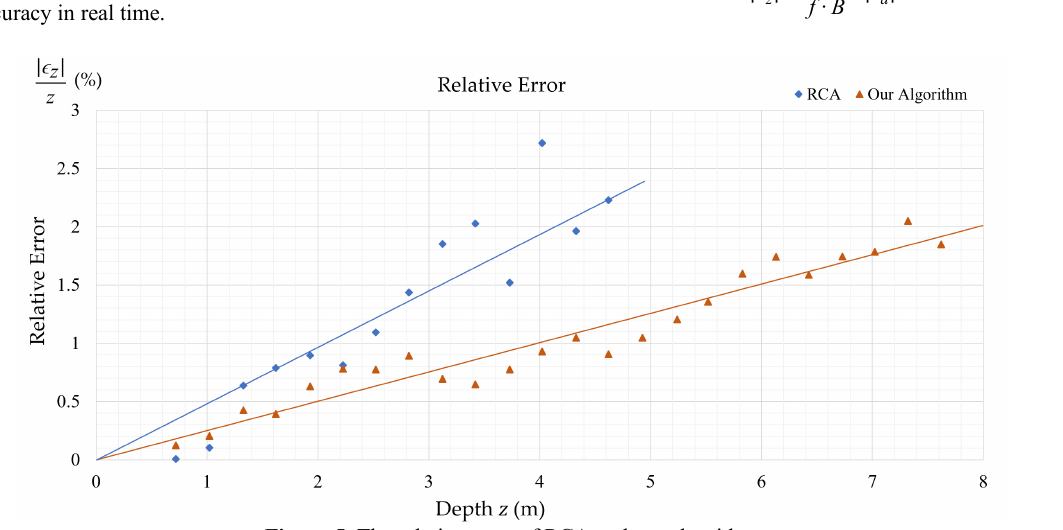
Figure 5 . The relative error of RCA and our